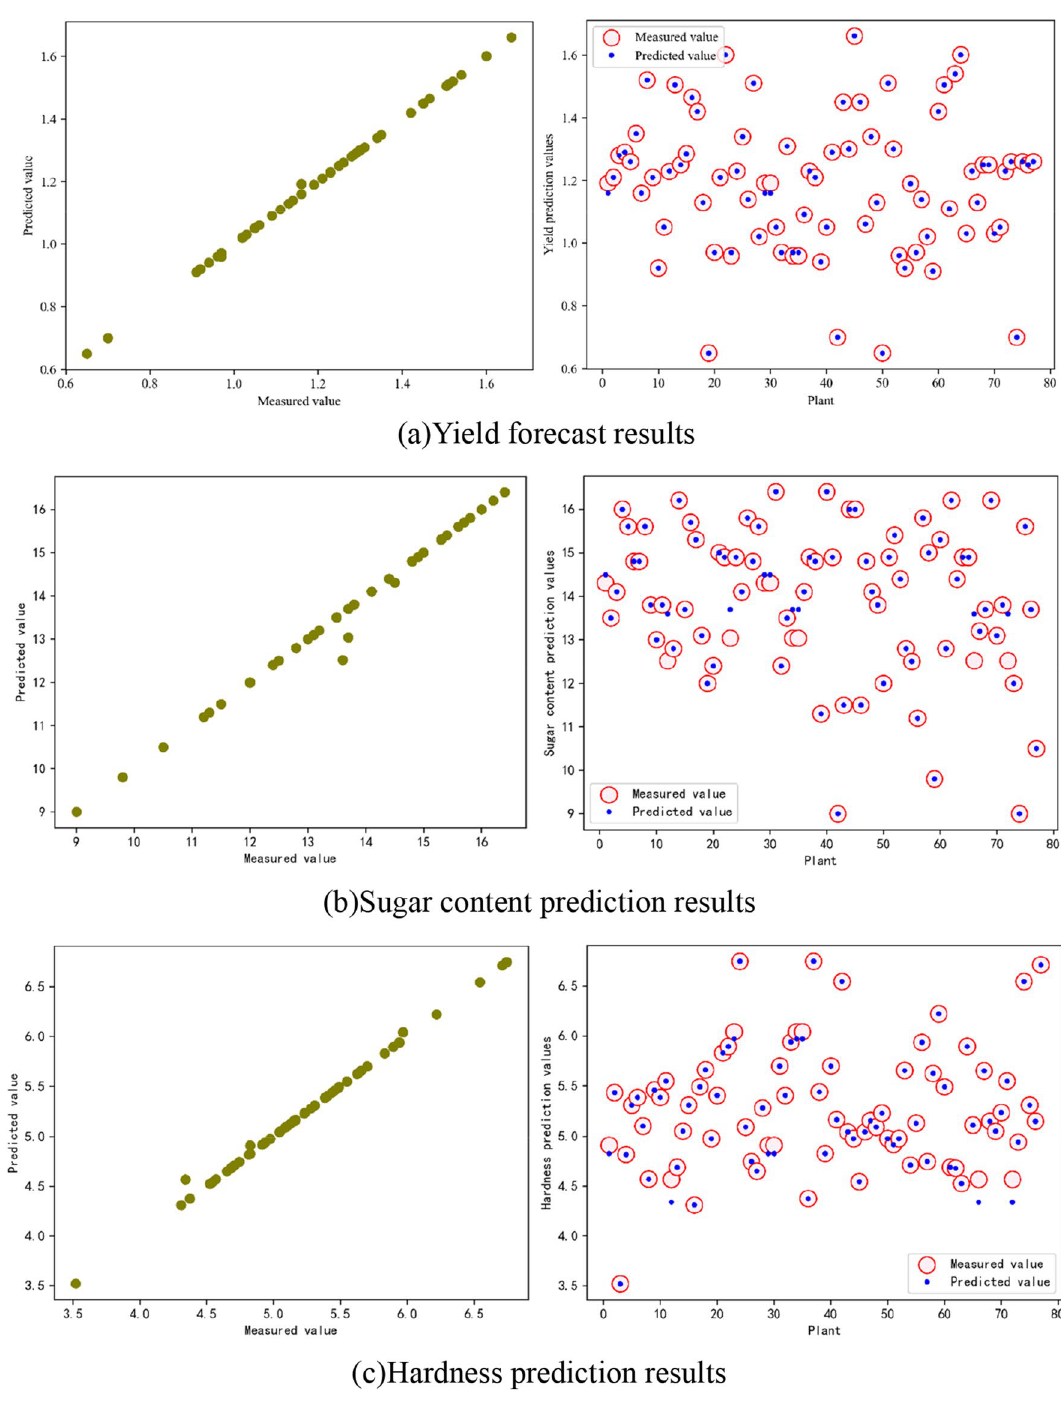
Figure 4. GBDT prediction